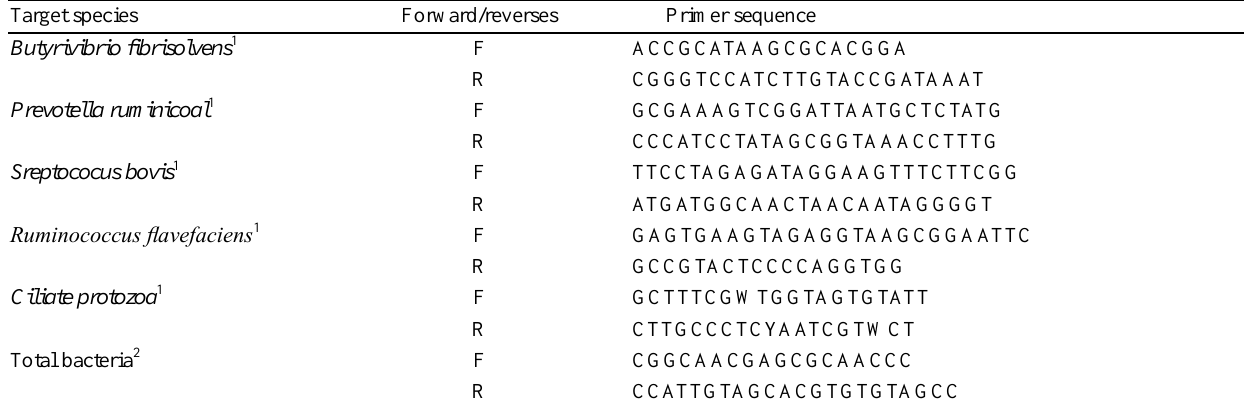
Table 3. PCR primers for real-time PCR assay Target